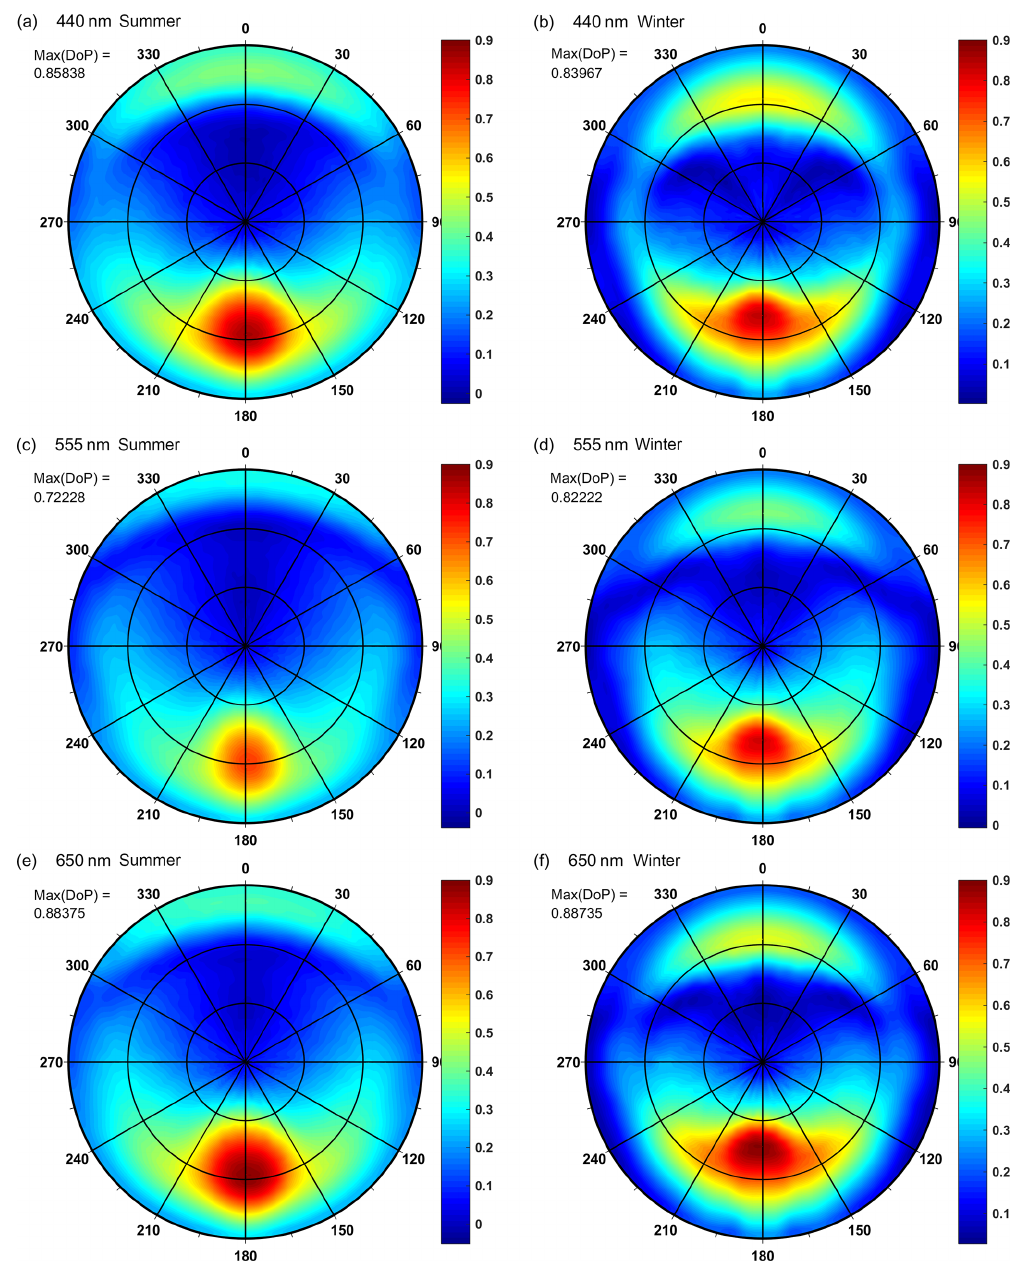
Figure 4. Simulation results of above-water upwelling radiance for average IOPs of open Baltic Sea water, for speed of wind of 5ms − 1 : (a) DoP in the summer season, λ = 440nm, SZA 45 ◦ , (b) DoP in the winter season, λ = 440nm, SZA 75 ◦ , (c) DoP in the summer season, λ = 555nm, SZA 45 ◦ , (d) DoP in the winter season, λ = 555nm, SZA 75 ◦ , (e) DoP in the summer season, λ = 650nm, SZA 45 ◦ , (f) DoP in the winter season, λ = 650nm, SZA 75 ◦ . Concentric circles inside mean zenith angles of 30 and 60 ◦ ,